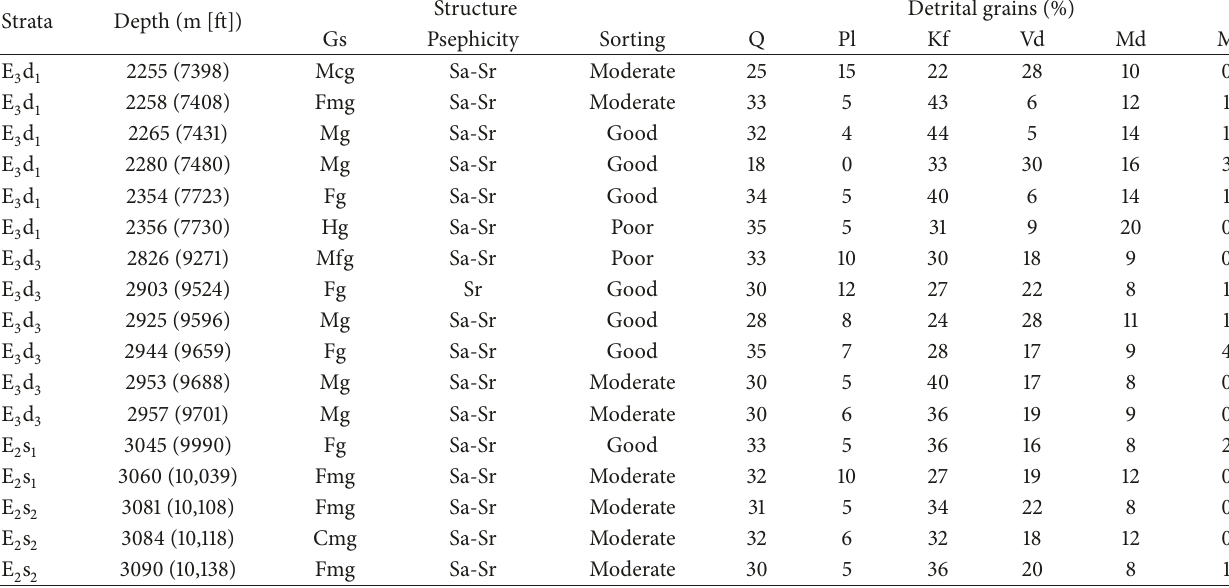
BZ-1 = Bozhong-1; Cmg = coarse-medium grained; E 3 d 1 = first member of the Paleogene Dongying Formation; E 3 d 3 = third member of the Paleogene DongyingFormation;E 2 s 1 =firstmemberofthePaleogeneShahejieFormation;E 2 s 2 =secondmemberofthePaleogeneShahejieFormation;Fg=finegrained; Fmg = fine-medium grained; Gs = grain size; Hg = heterogranular; Kf = K-feldspar; M = mica; Mcg = medium-coarse grained; Md = metamorphic detritus; Mfg = medium-fine grained; Mg = medium grained; Pl = plagioclase; P = psephicity; Q = quartz; Sa-Sr = subangular-subrounded; Sr = subrounded; Vd = volcanic